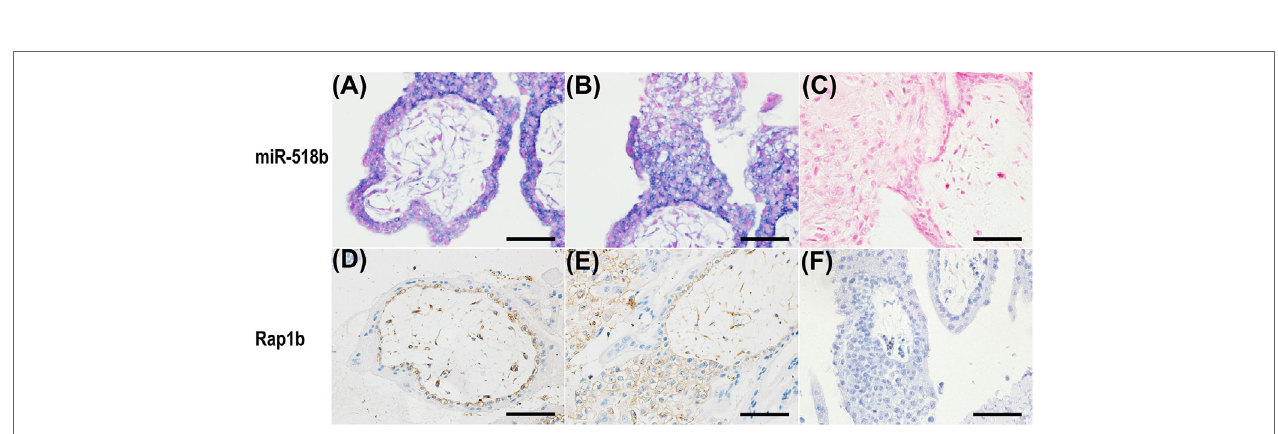
FigUre 2 | Localization of miR-518b and Rap1b in human placental villi. (a,b) The miR-518b expression was measured by in situ hybridization (blue) in human placental villi (a) and trophoblast cell column (b) at gestational weeks 7–9. (D,e) The localization of Rap1b was detected by immunohistochemistry in human placental villi (D) and trophoblast cell column (e) . (c,F) showed the negative control of miR-518b (scrambled miR) and Rap1b (rabbit igG). Scale bar represent 50 µm.